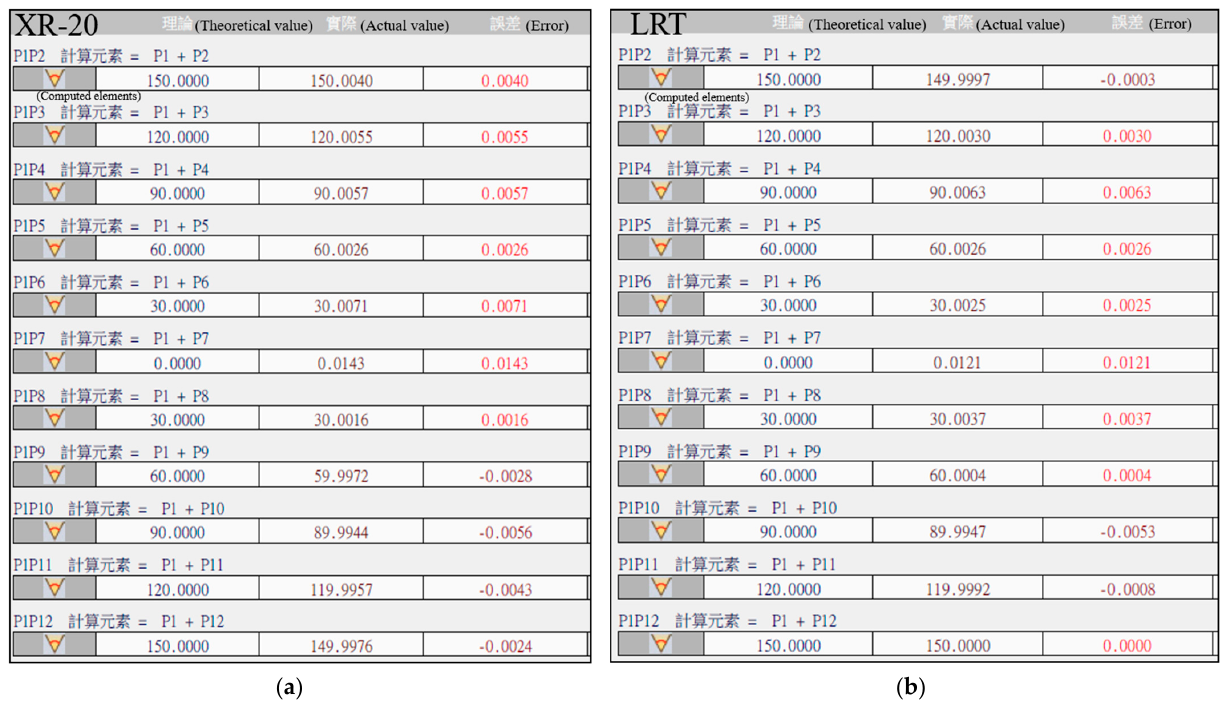
Figure 27. The measured result from CMM ABLE-686-CNC: ( a ) results from the workpiece using XR-20W and ( b ) results from the workpiece using Laser R-test.